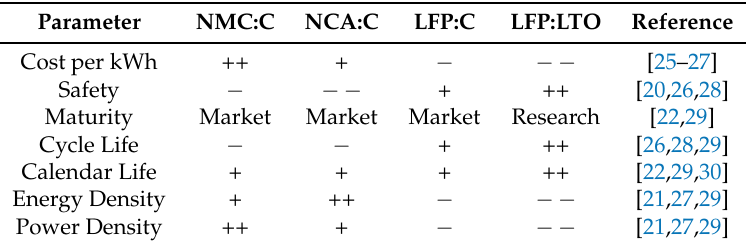
Table 2. Qualitative comparison of literature values for performance parameters of Lithium-ion battery cells used for stationary storage systems.